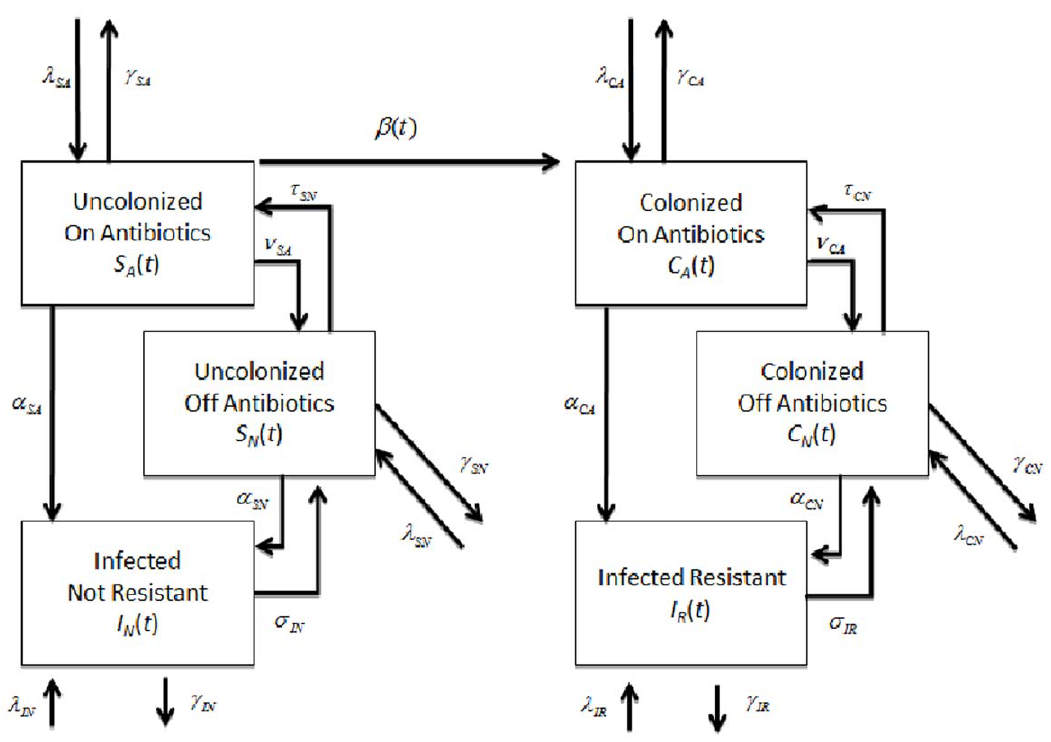
Figure 1. A compartmental model describing the transmission dynamics of MDROs in a 600-bed hospital. The arrows and parameter values correspond to entry and exit from the 6 compartments ( S A -susceptible patients receiving antibiotics, S N -susceptible patients not receiving antibiotics, I N -patients infected with a non-resistant strain, C A -patients colonized with an MDRO that are receiving antibiotics, C N -patients colonized with an MDRO not receiving antibiotics, and I R -patients infected with an MDRO). The following parameters were used: 100 l , percentage of patients being admitted to each compartment; 1/ c , length of hospital stay; t , rate that patients start receiving antibiotics; n -rate that patients discontinue antibiotics; a , rate that colonized patients become infected; s , rate that infected patients are successfully